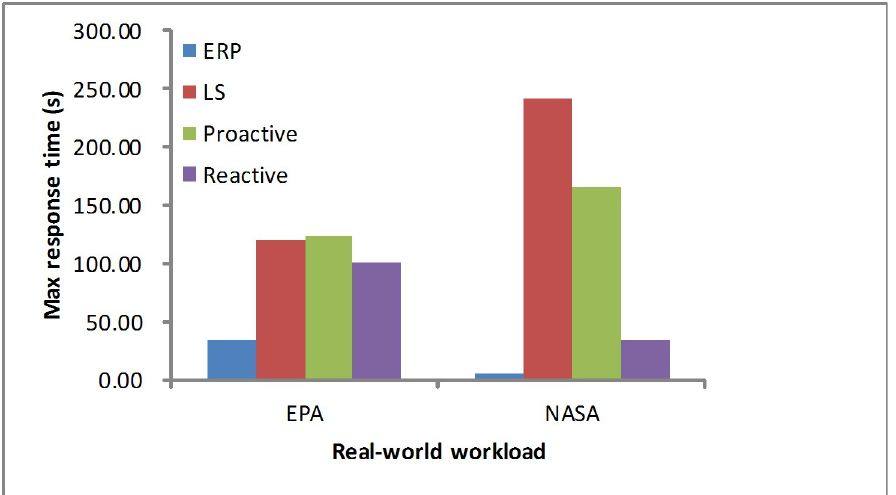
Fig 14. Max response time in the real-world